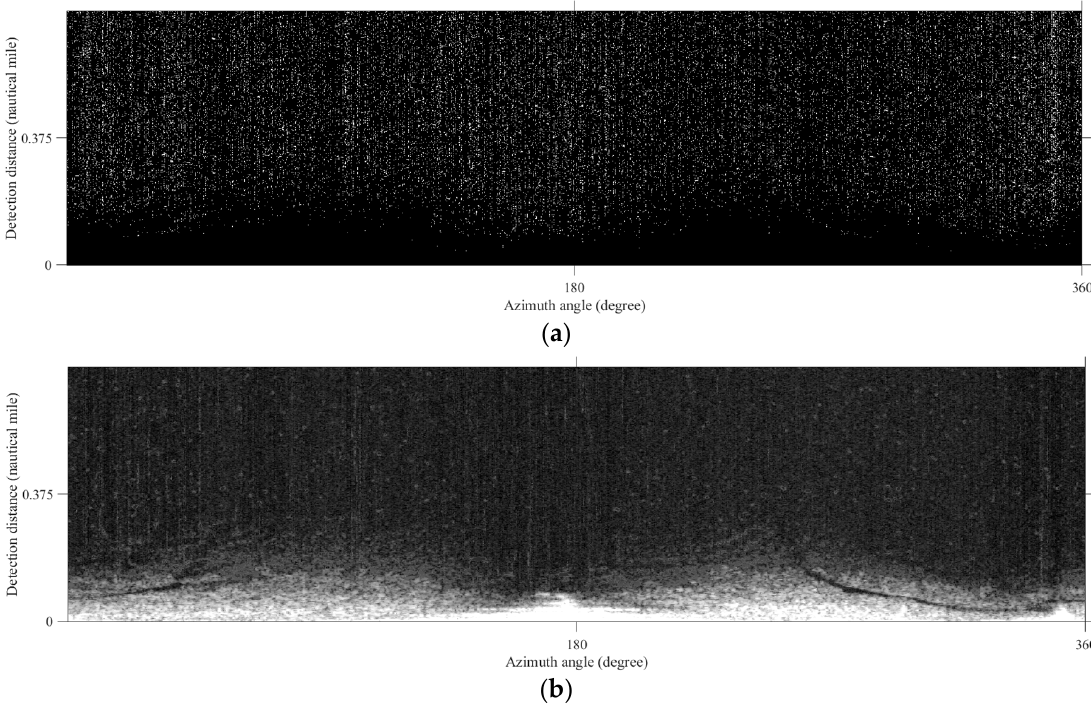
Figure 2. Image preprocess: ( a ) the noises were segmented; ( b ) the noise-reduced